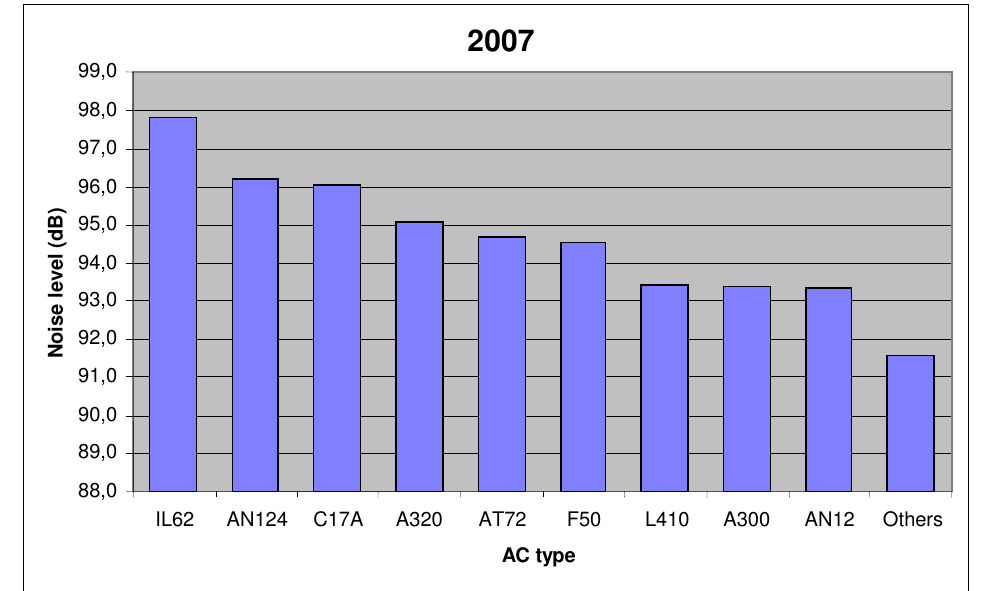
Fig 1. Airplanes emitting the highest noise level